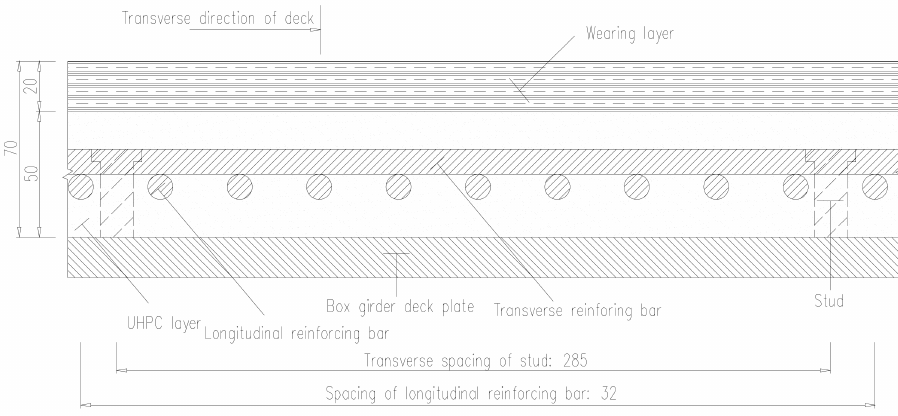
Figure 3. Layout of reinforcing bars and studs (unit: